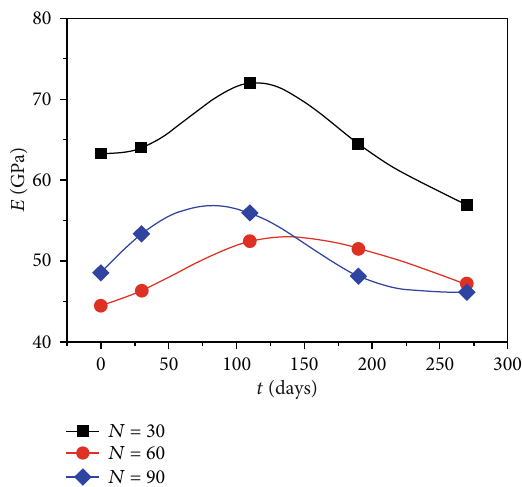
Figure 2: The variation curves of concrete elastic modulus and corrosion time under di ff erent freeze-thaw